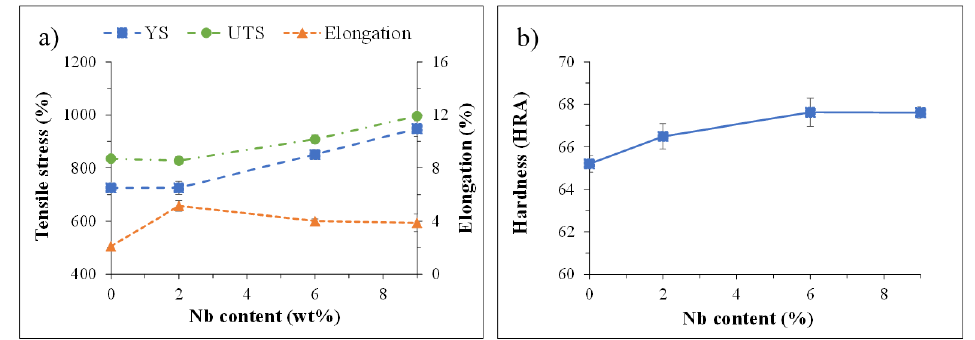
Figure 6. Average mechanical properties of the Ti-5Fe-xNb alloys: ( a ) tensile properties, and ( b ) hardness. Ti-5Fe data from ref. [37].